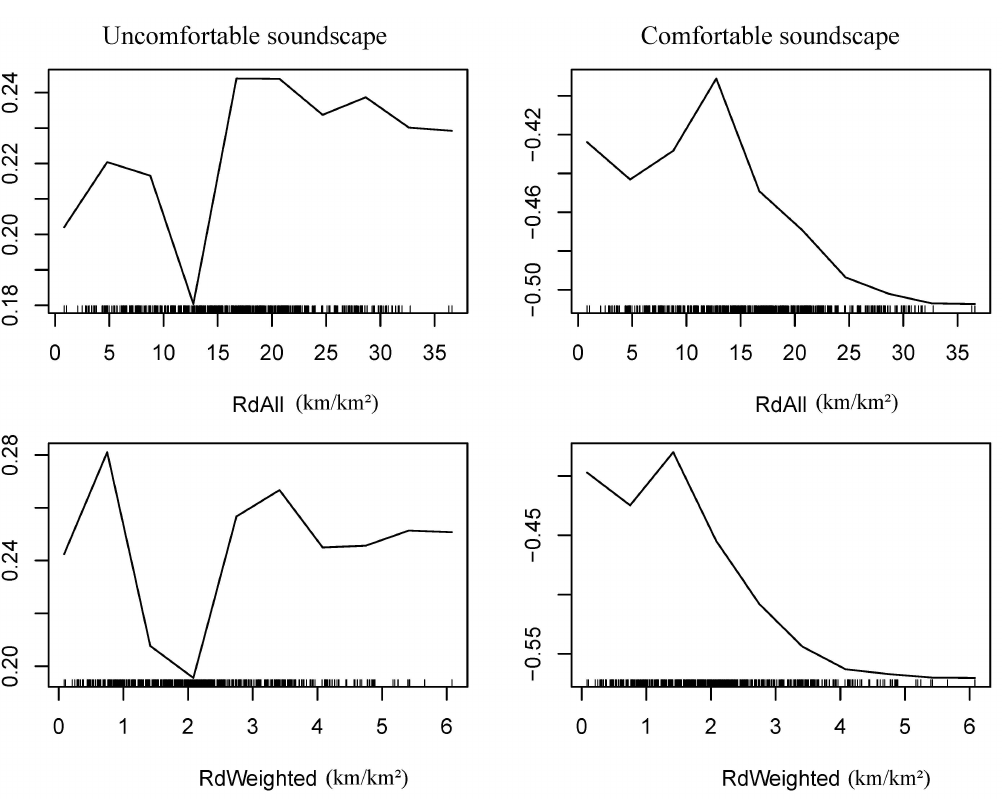
Figure A2. Partial dependence plot to understand the marginal effect of a single predictor on model prediction outcomes.